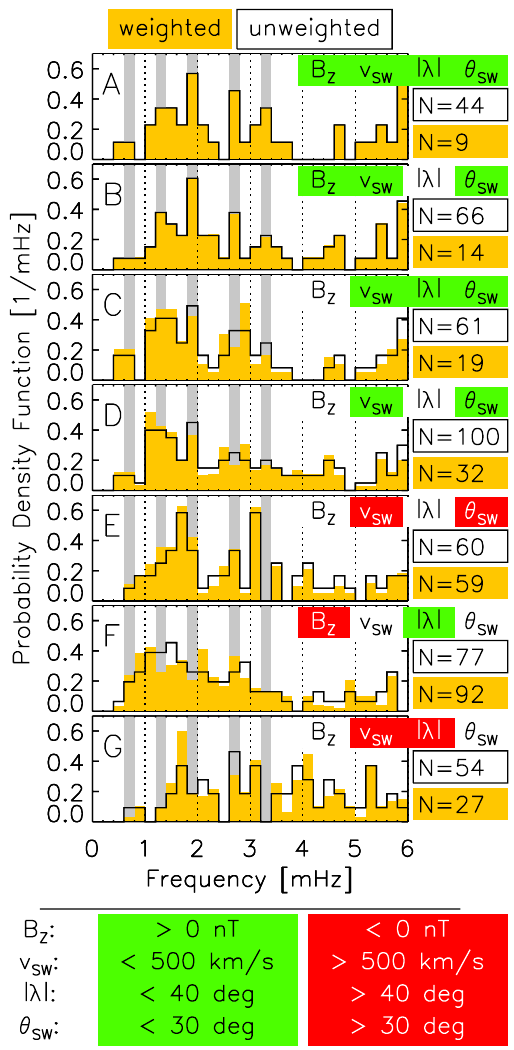
Fig. 5. Probability density functions of MP oscillation frequen- cies in the interval between 0 and 6mHz derived from unweighted (solid lines) and weighted (yellow bars) events. The conditions applied are given in the upper right corners of each panel (A) to (G) . The color code indicates the condition with regard to each pa- rameter according to the legend given below all panels. No green or red background indicates, that no selection of events was per- formed with regard to the specific parameter. Numbers ( N ) on the right side of each panel show the (real/fictitious) numbers of (un- weighted/weighted) events contributing to the corresponding dis- tribution. Grey bars display the positions of the fundamental fre- quency